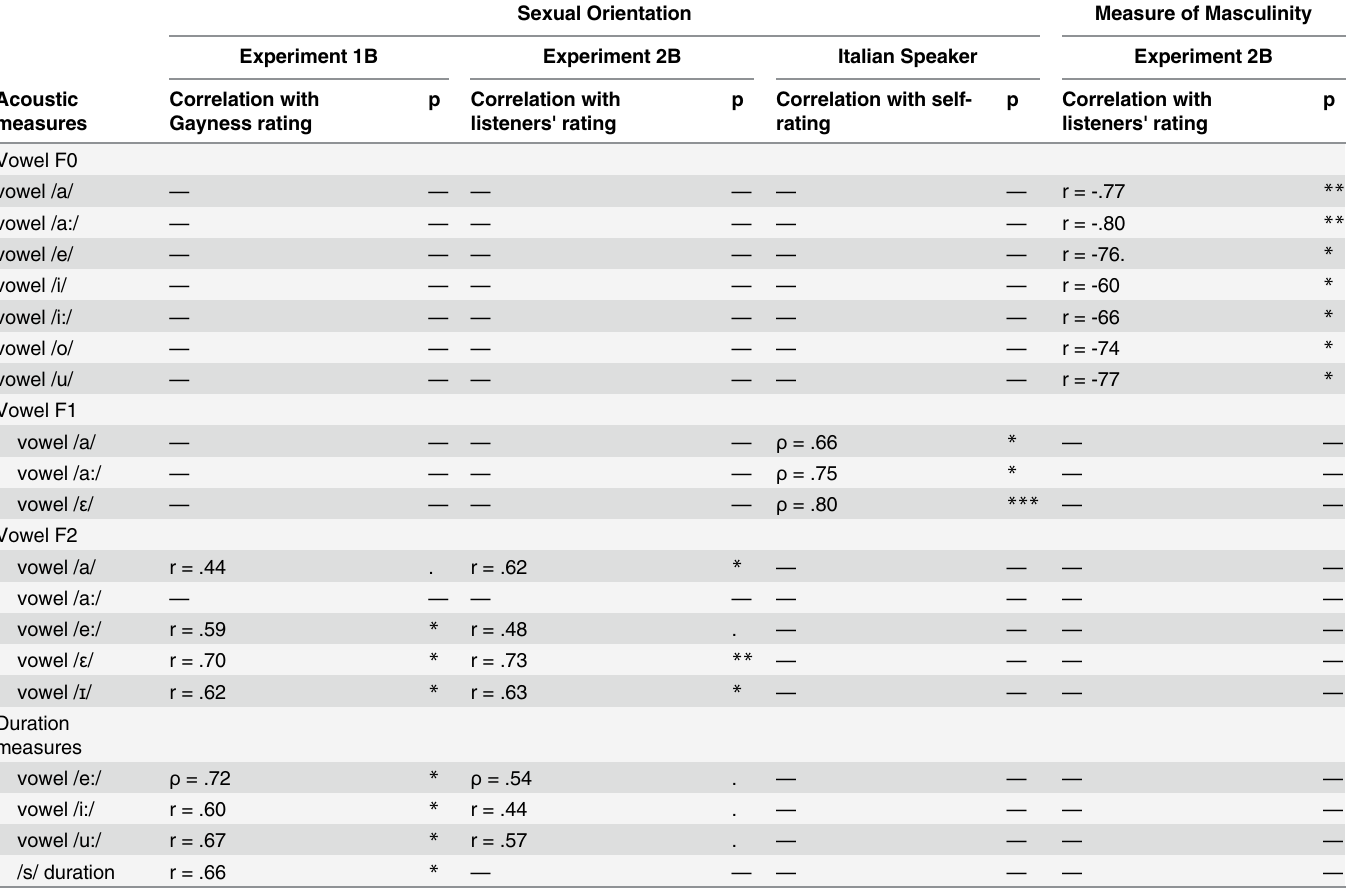
Table 2. Germans – Significant correlations between acoustic cues and participants' judgments of Experiment 1B, 2B, and self-reported speakers'